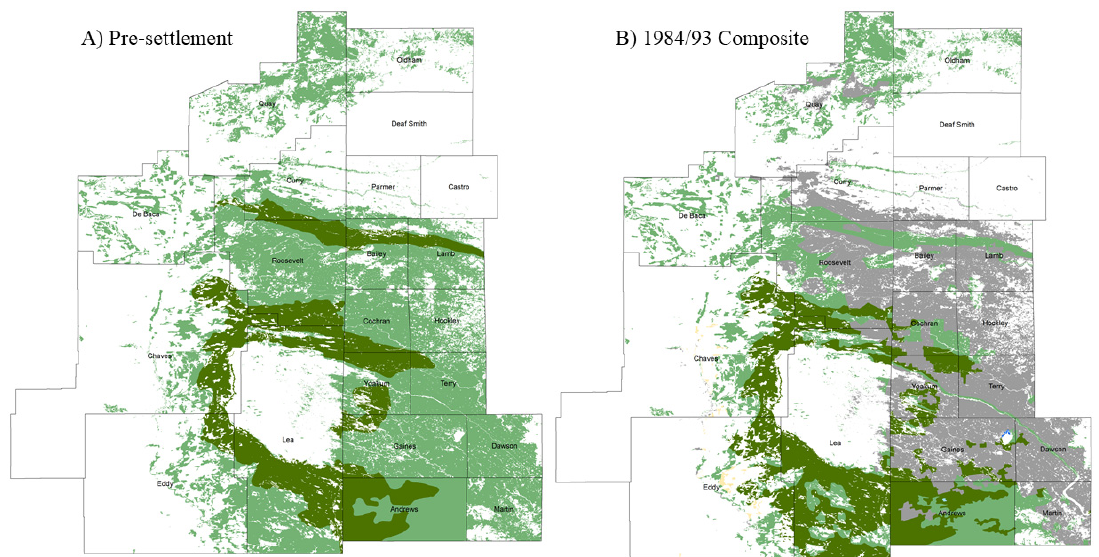
Figure 3. Location of sand shinnery oak-dominated land (dark green) and mixed grasslands (light green) and anthropogenic (grey) land-cover types for ( A ) historical pre-settlement conditions and ( B ) ca. 1980 conditions based on Dick-Peddie (1993) and TPWD (1984) vegetation maps.